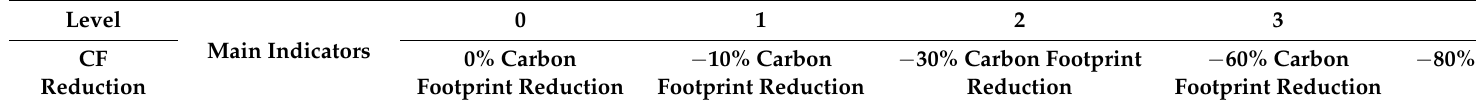
Table 5. Production